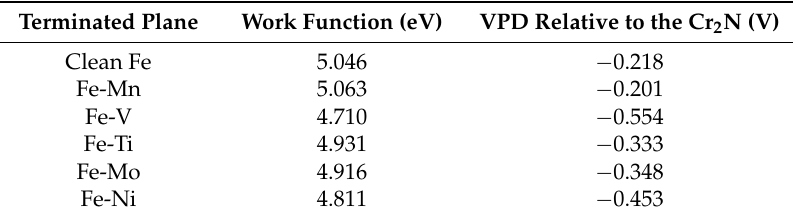
Table 4. Volta potential differences of γ -Fe (111)/Cr 2 N(0001) and after M (M = Mn, V, Ti, Mo, and Ni) atom is introduced.